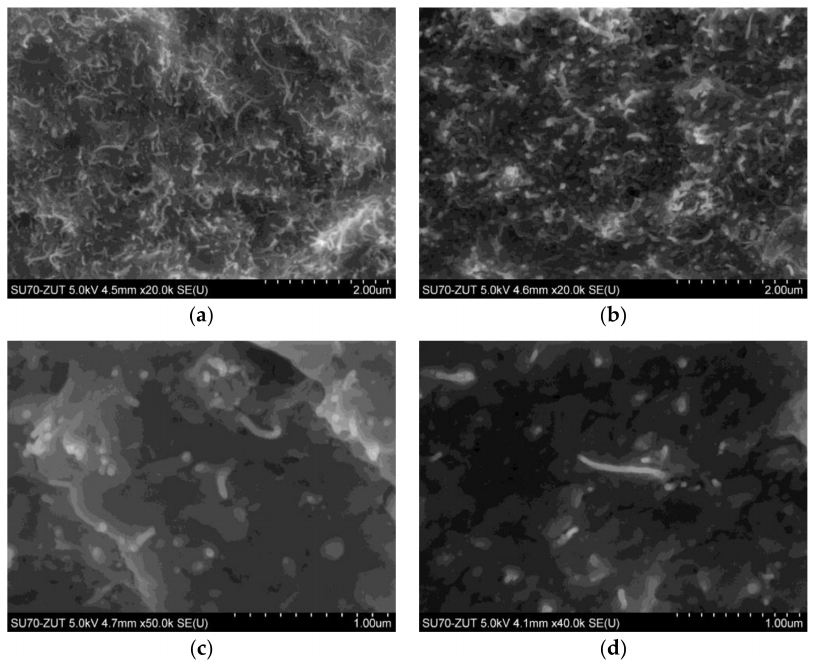
Figure 1. Scanning electron microscopy (SEM) images of: ( a ) LDPE/20 wt. % MWCNTs; ( b ) LDPE/